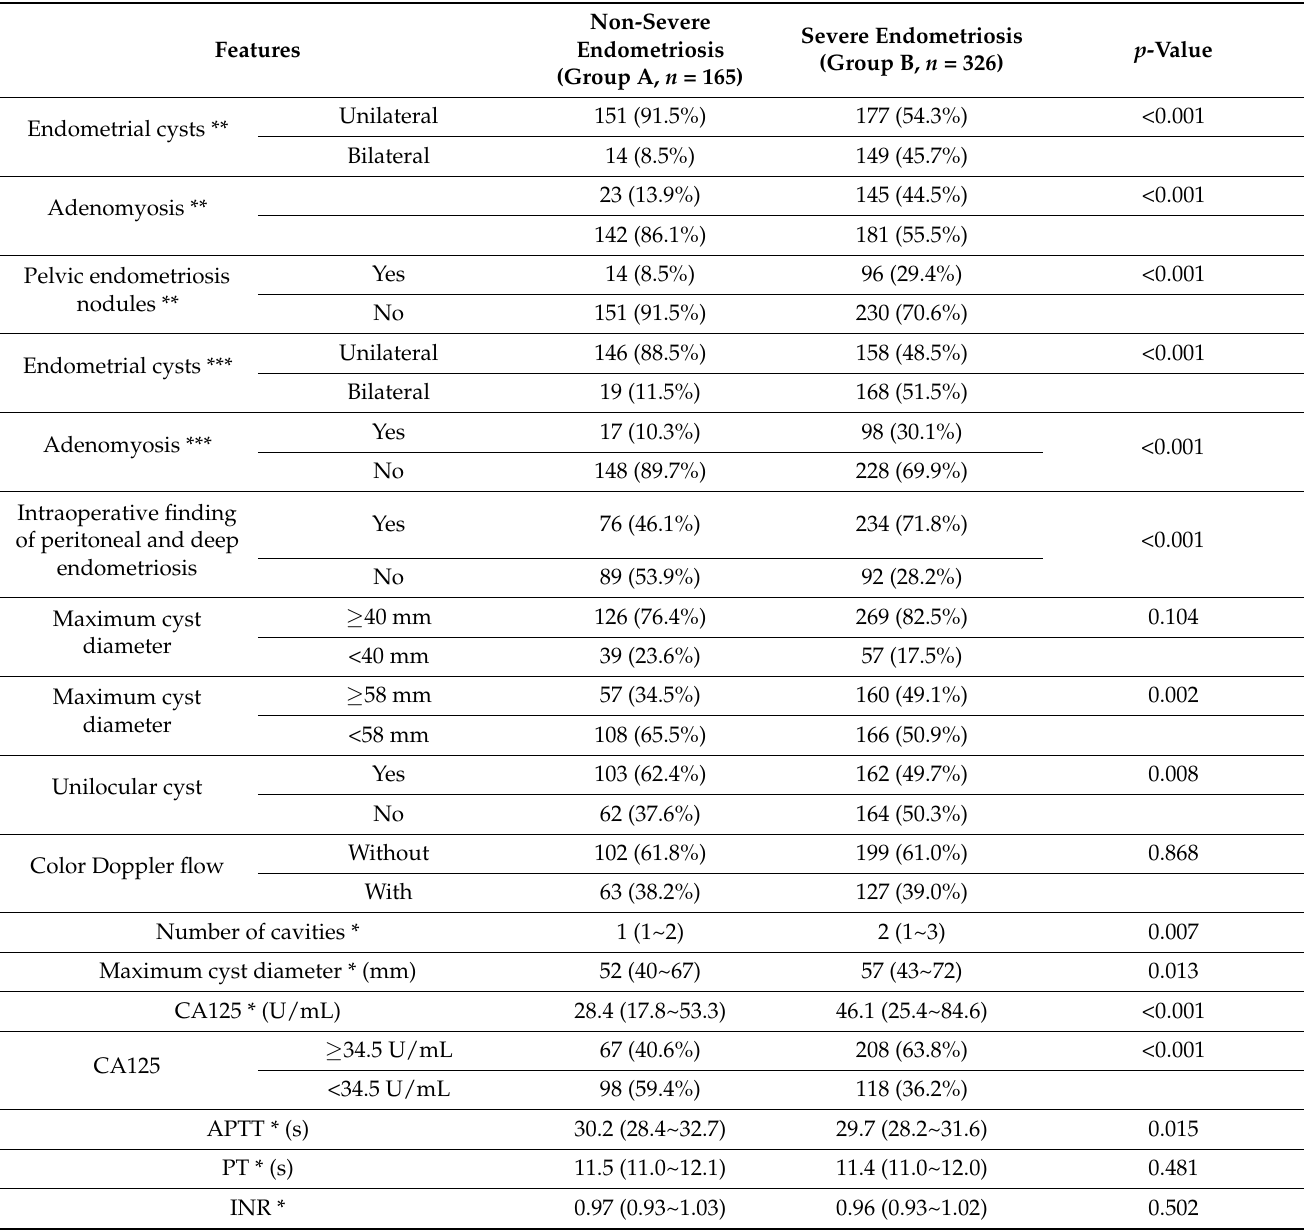
Table 2. Preoperative and intraoperative/pathological